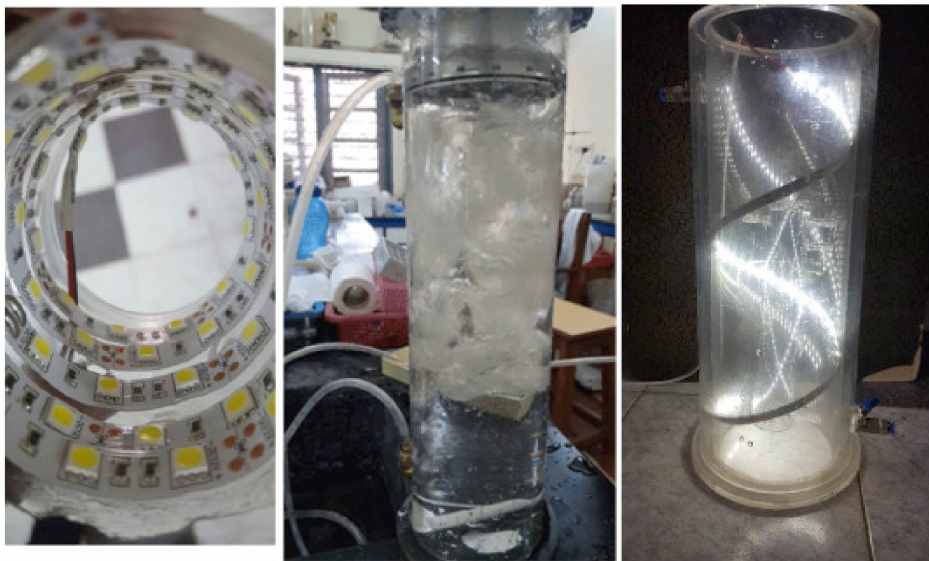
Figure 1. Fluidized-bed-type LED reactor with immobilized catalyst on polymer supports; repro- duced with permission from [39], Copyright 2019, Elsevier.